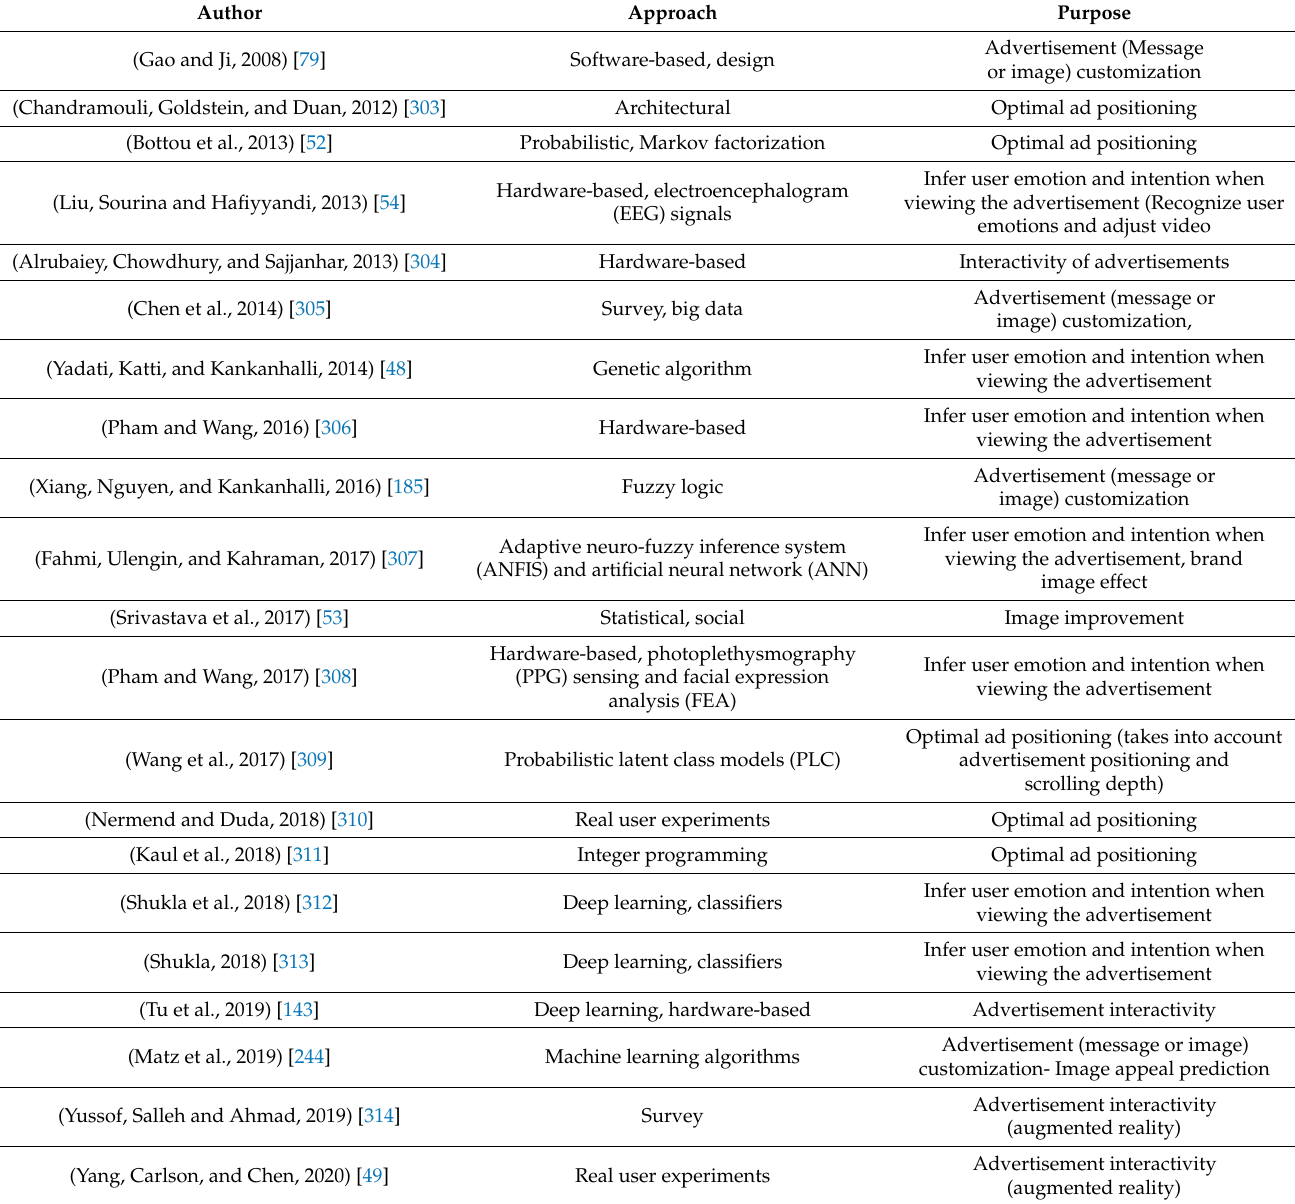
Table A6. Works in advertisement interactivity and